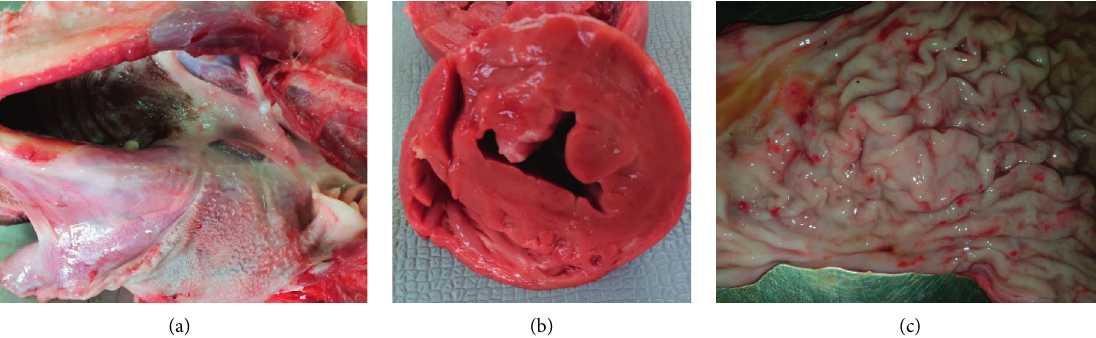
Figure 3: Main postmortem macroscopic lesions detected in a Leishmania -positive dog. (a) Ulcerative lesions at the edges of the tongue. (b) Transverse section of the heart showing a hypertrophy of the left ventricle and atrophy and dilatation of the right one. (c) Mucous membrane of the stomach of a Leishmania -positive dog, showing petechiae and hemorrhagic suffusions.